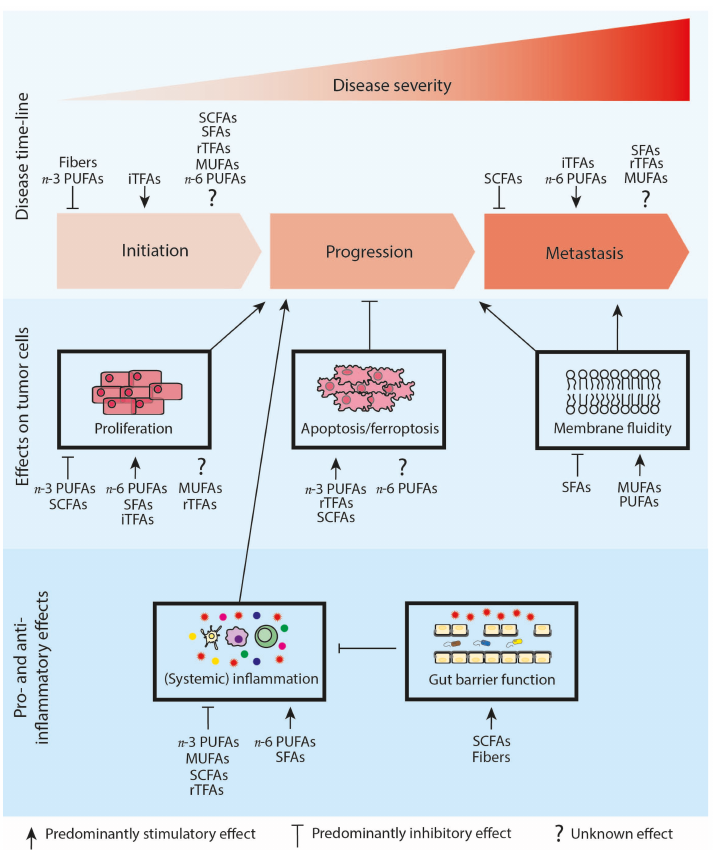
Figure 2. Schematic overview of the relationship between the different fatty acid classes and cancer initiation, progression and metastasis. Cancer risk: iTFAs increase the risk of cancer initiation, while dietary fibers and n -3 PUFAs in general seem to decrease the risk of cancer initiation. For SCFAs, SFAs, rTFAs, MUFAs and n -6 PUFAs information remains controversial. Cancer progression: n -3 PUFAs